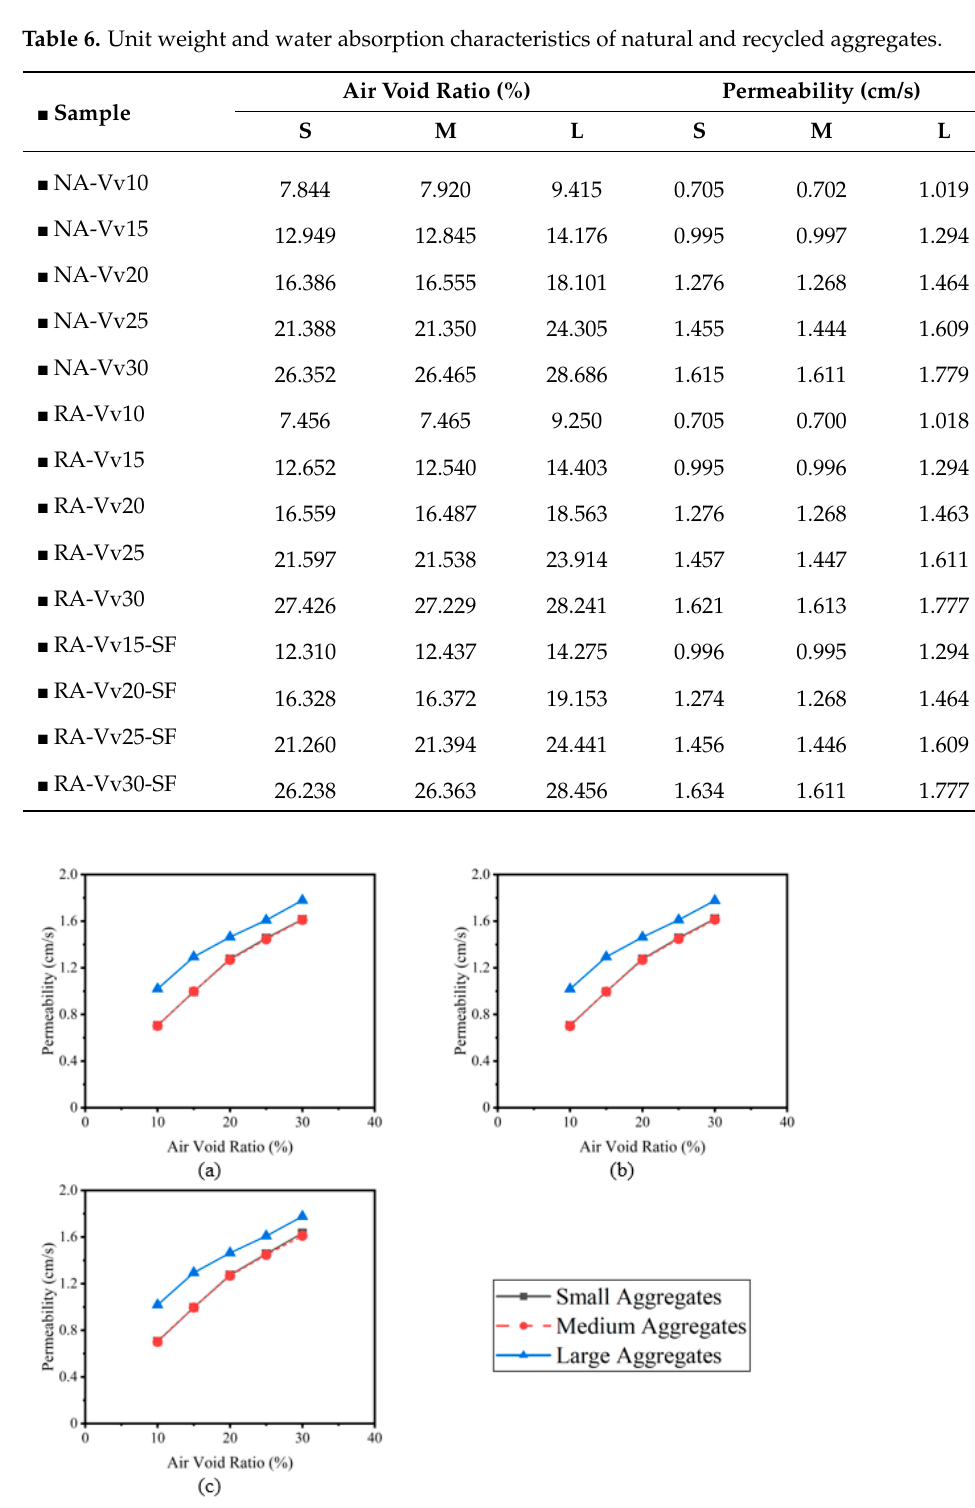
Figure 7. Variation of permeability of PPCC with an air void ratio: ( a ) natural aggregate PPCC, ( b ) recycled aggregate PPCC, and ( c ) recycled aggregate PPCC strengthened with sackcloth fibers. Table 6. Unit weight and water absorption characteristics of natural and recycled aggregates.